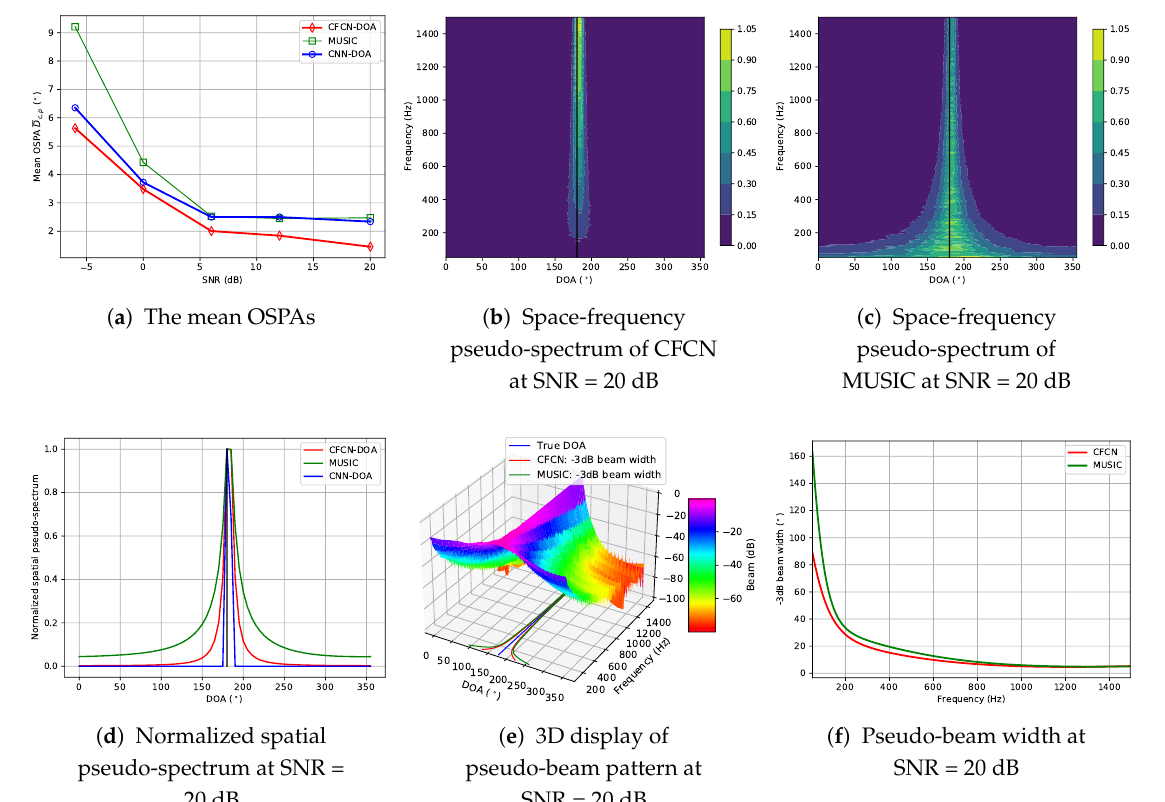
Figure 5. The results of the simulation under the full-frequency single-source condition. (ii) Dual-source situation: The true DOAs of two sources are set to 92.5 ◦ and 227.5 ◦